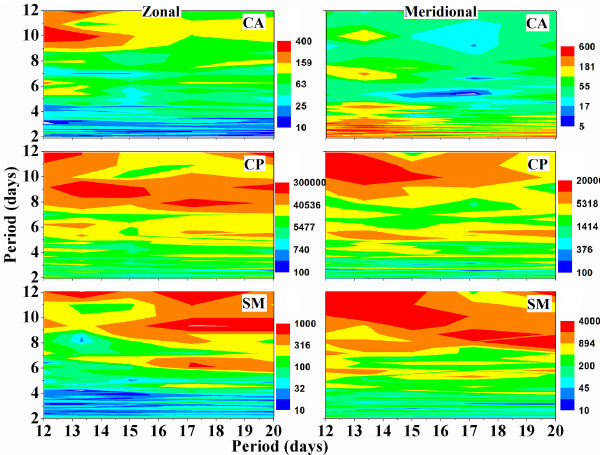
Figure 9. Same as Fig. 8, but it is at 10hPa pressure level.